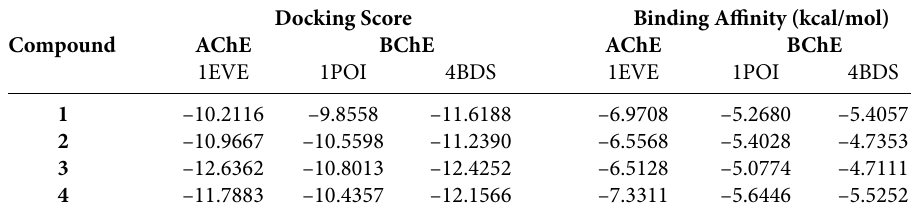
Table 5. Docking results of synthesized